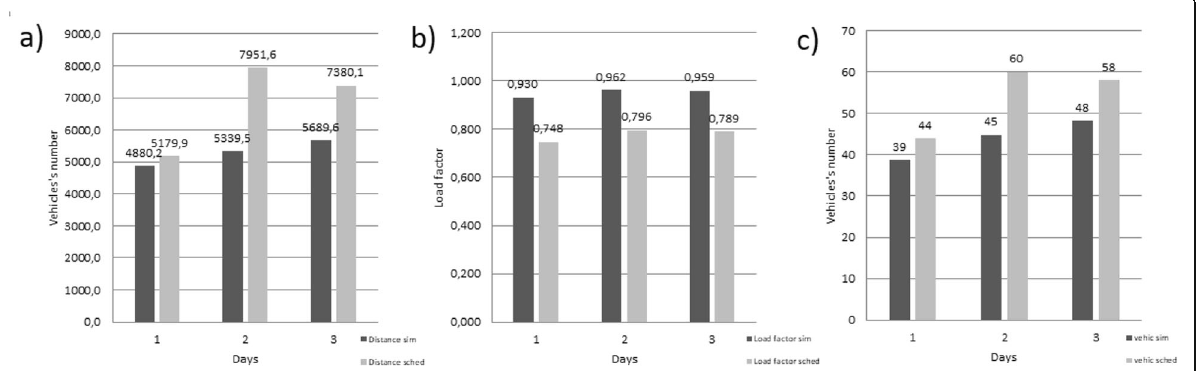
Fig. 7 Comparison between simulated and scheduled ( a ) total travel distance and ( b ) load factors ( c ) number of